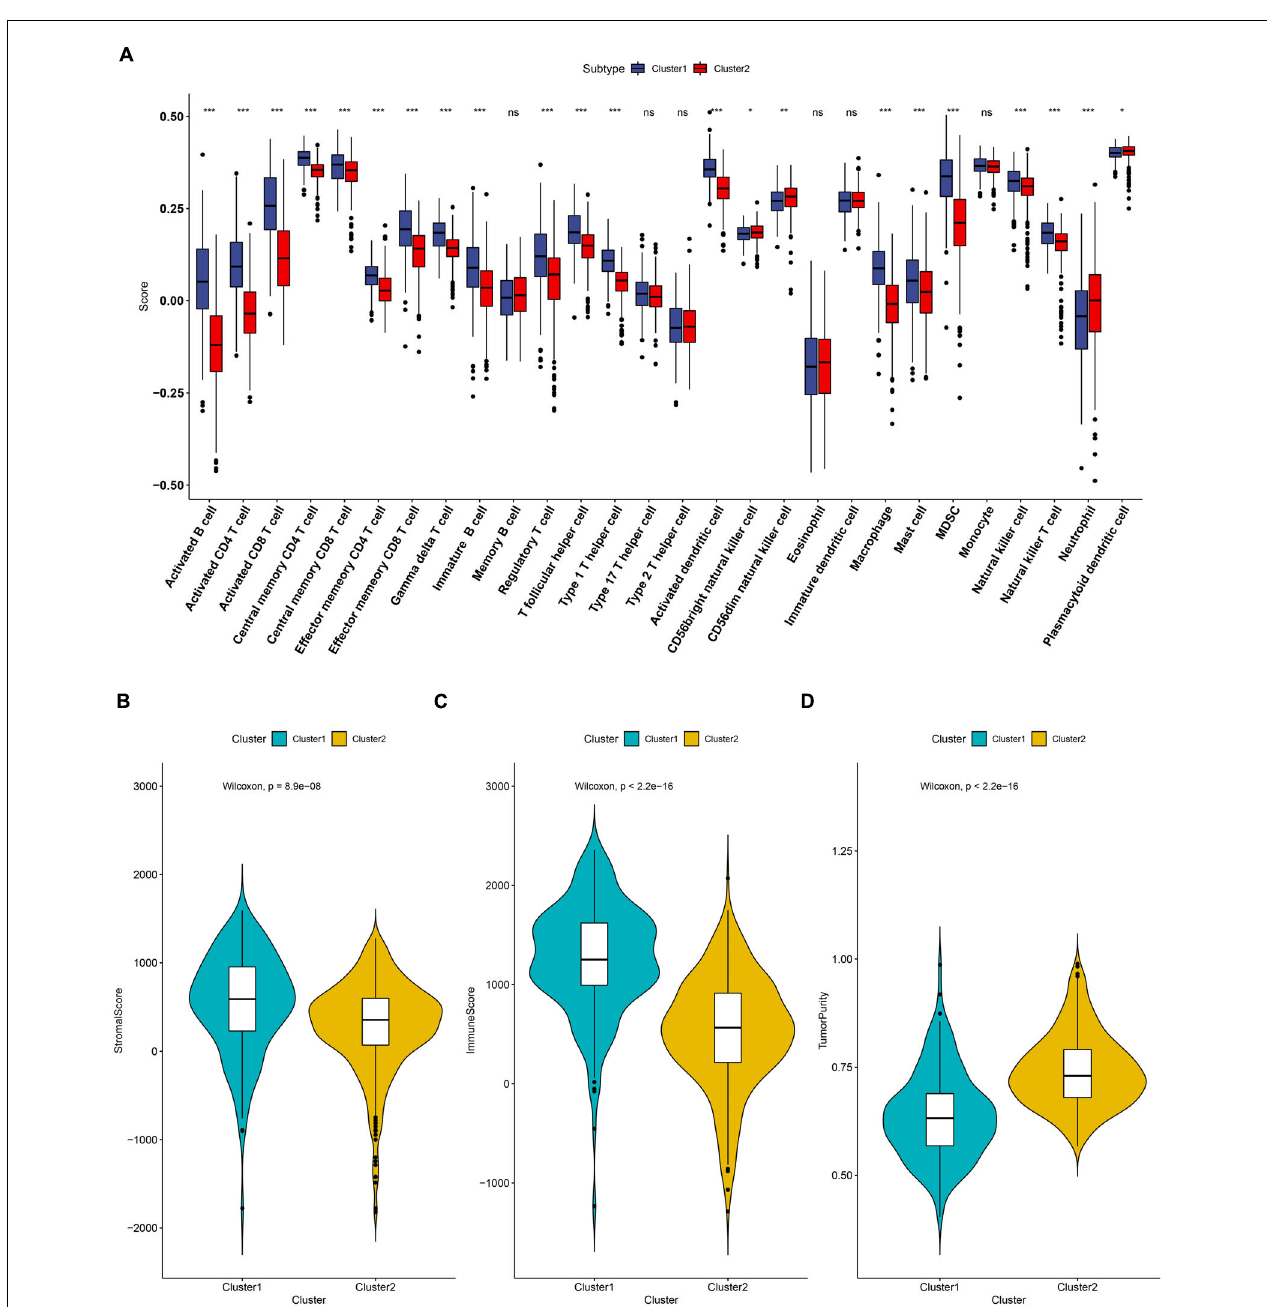
FIGURE 2 | The landscape of immune cell infiltration in the two subtypes. (A) Twenty-eight immune cells’ infiltration levels that were calculated by the ssGSEA algorithm in the two subtypes. The comparisons of stromal score (B) , immune score (C) and tumor purity (D) between the two subtypes. ns: not significant, * P < 0.05, ** P < 0.01, *** P < 0.001.